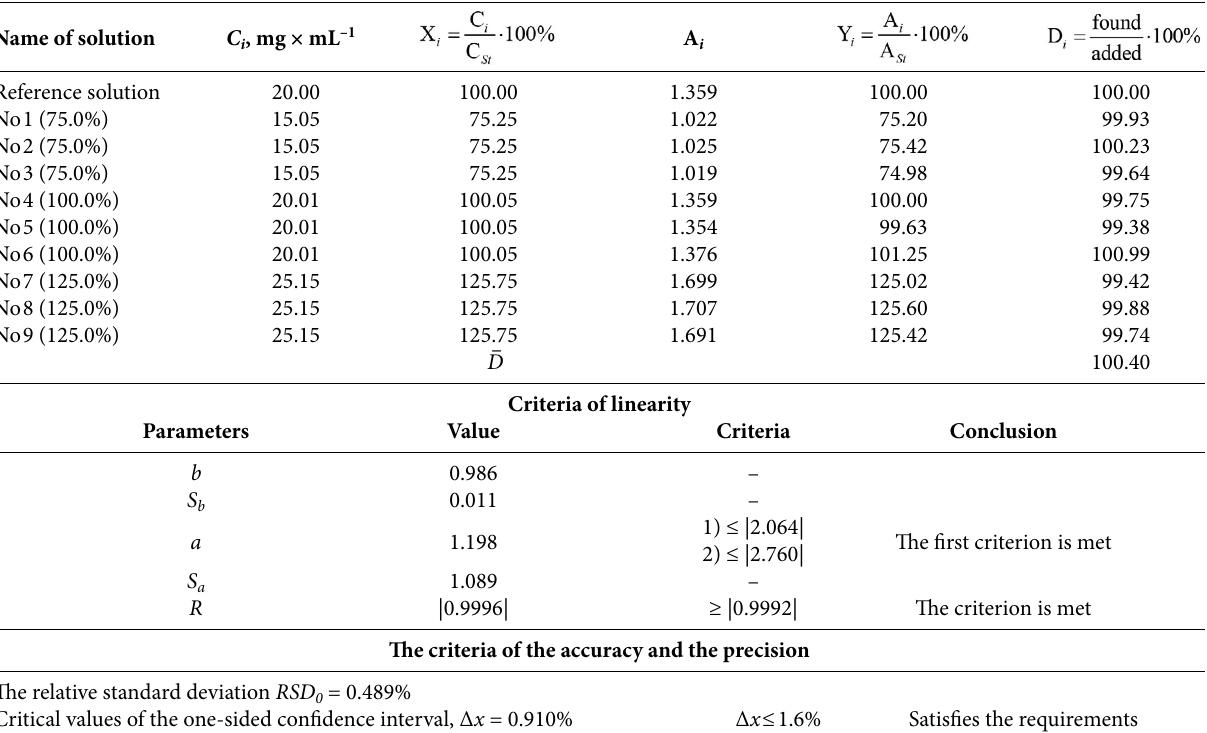
Table 7. The criteria of the linearity, the accuracy, and the precision of AM determination using SA in the preparation of “Amoxil” tablets. Name of